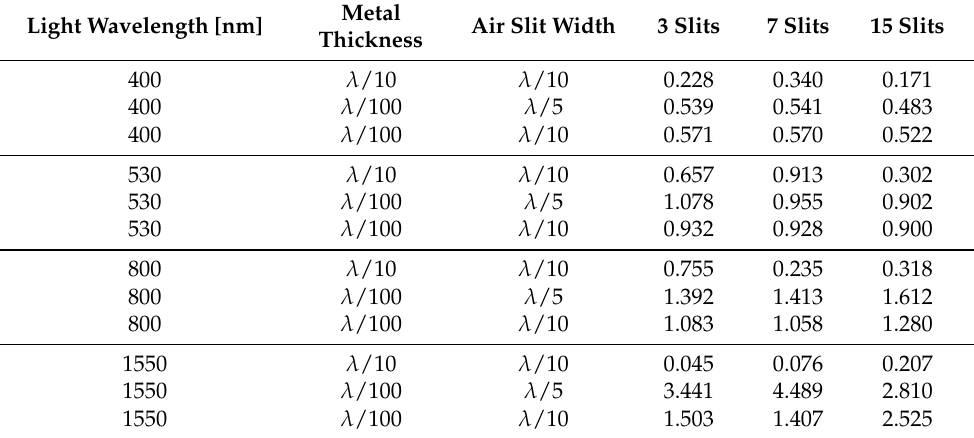
Table 3. Maximum absolute values of the normalized electric field along the intrinsic region for a gold